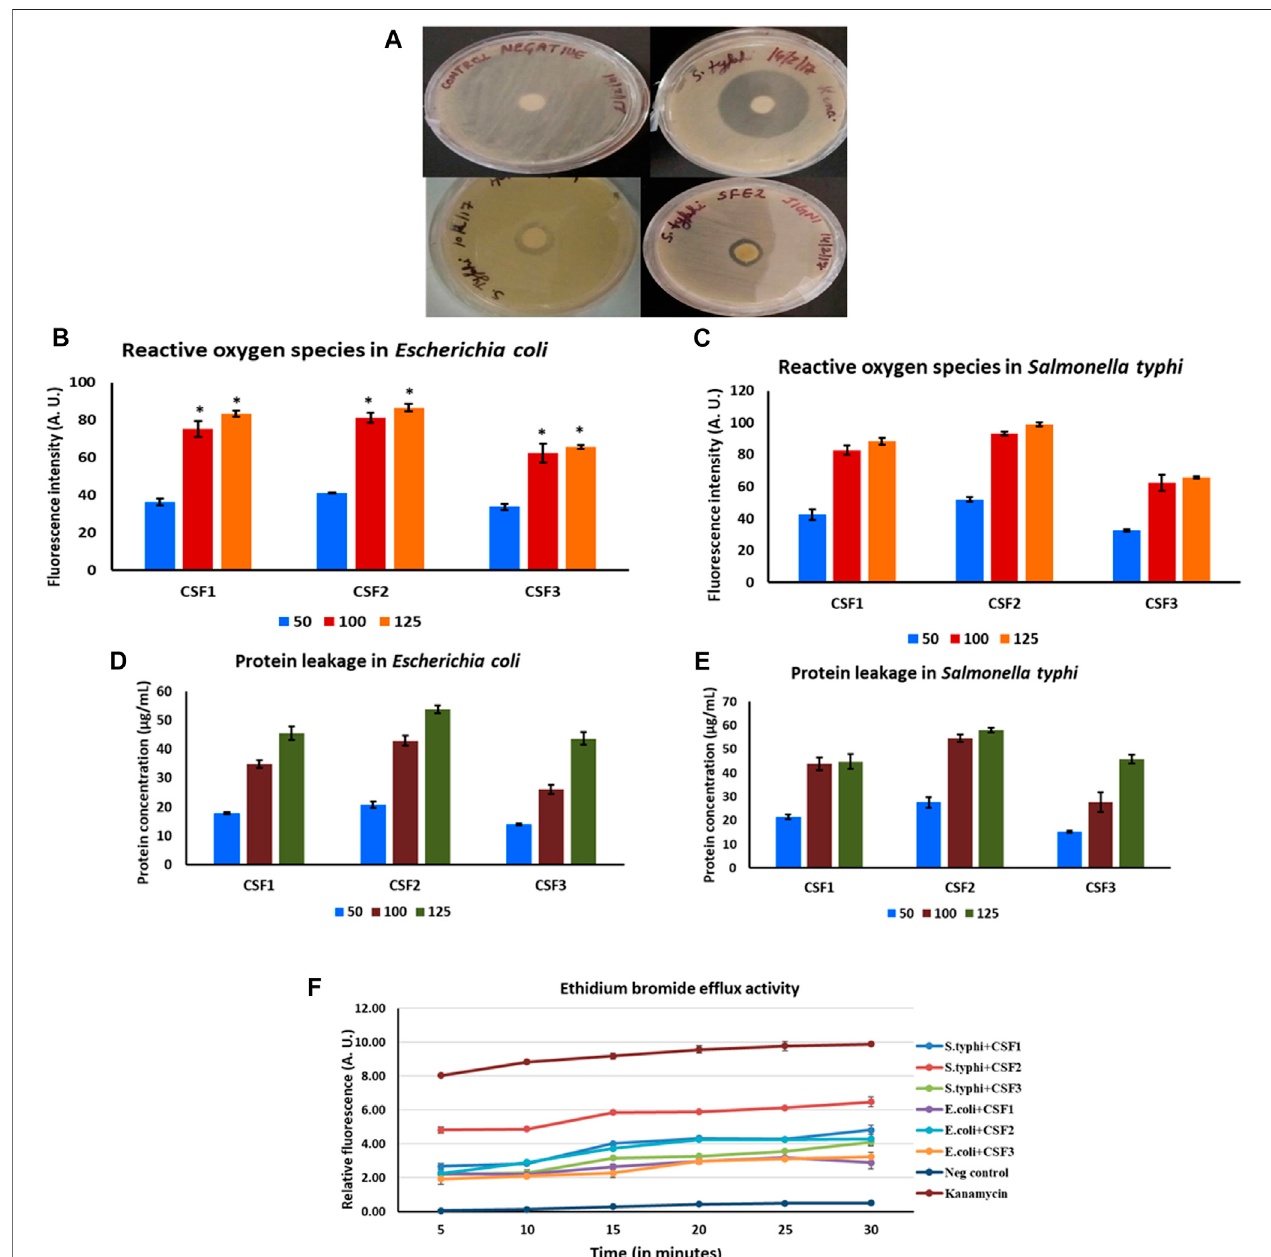
FIGURE 8 | Distinct zones of inhibition after treatment with CSF1 and CSF2 extracts, against pathogenic Salmonella typhi can be clearly seen (A) . Generation of reactive oxygen species after treatment with different doses (50, 100, 125 µg/ml) of Cordyceps sinensis supercritical fl uid extracts within E. coli (B) and S. typhi (C) was deducedasapotentialantibacterialmodeofaction. Induction ofprotein leakageofaforesaidextractsagainst E.coli (D) and S.typhi (E) wascon fi rmedtobeyetanother inhibitory mechanism. The supercritical fl uid extracts also led to inhibition of ef fl ux pump activities in the bacterial cells (F) . Nutrient broth and kanamycin acted as negative and positive controls, respectively. Data are expressed as mean ± SD ( n (cid:1) 3). * represents signi fi cant change at level of p < 0.05.